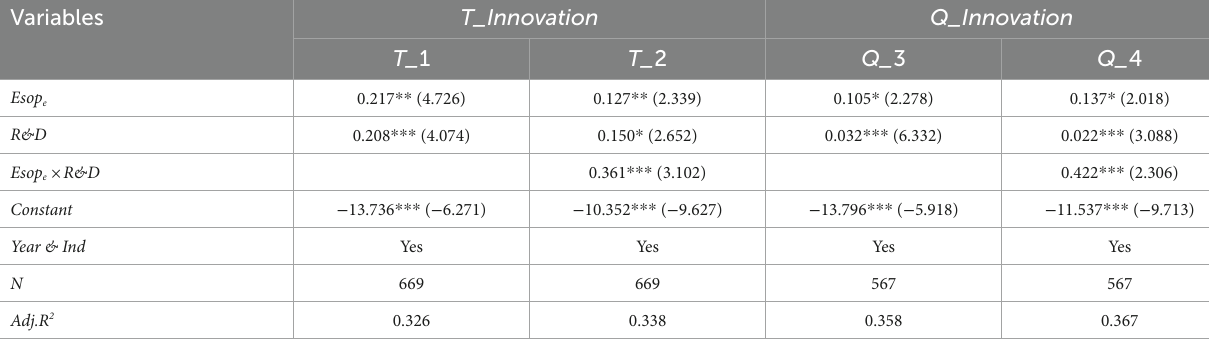
TABLE 9 The moderating effect of R&D investment on employee equity incentives and enterprise